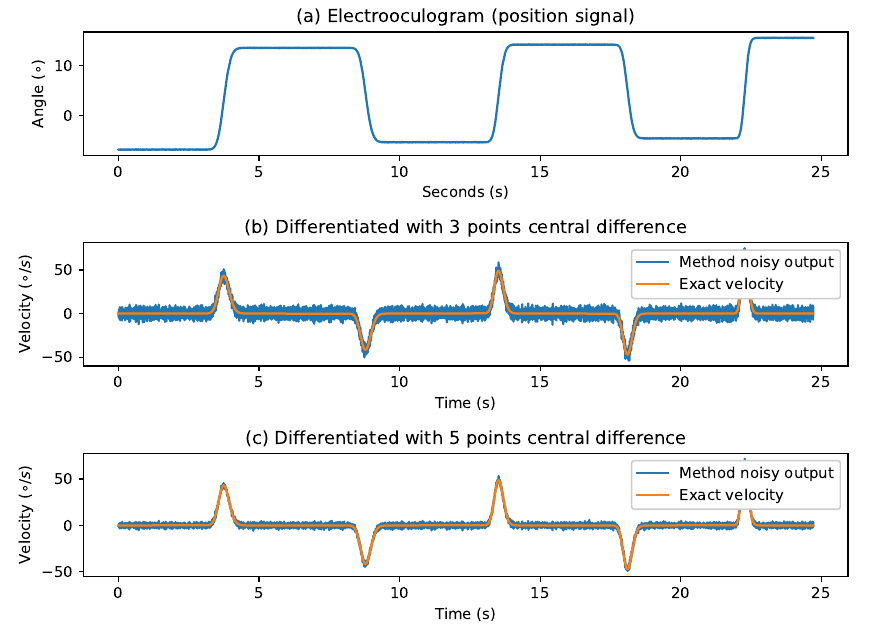
Figure 1. An example of an electrooculogram differentiated using the central difference of 3 and 5